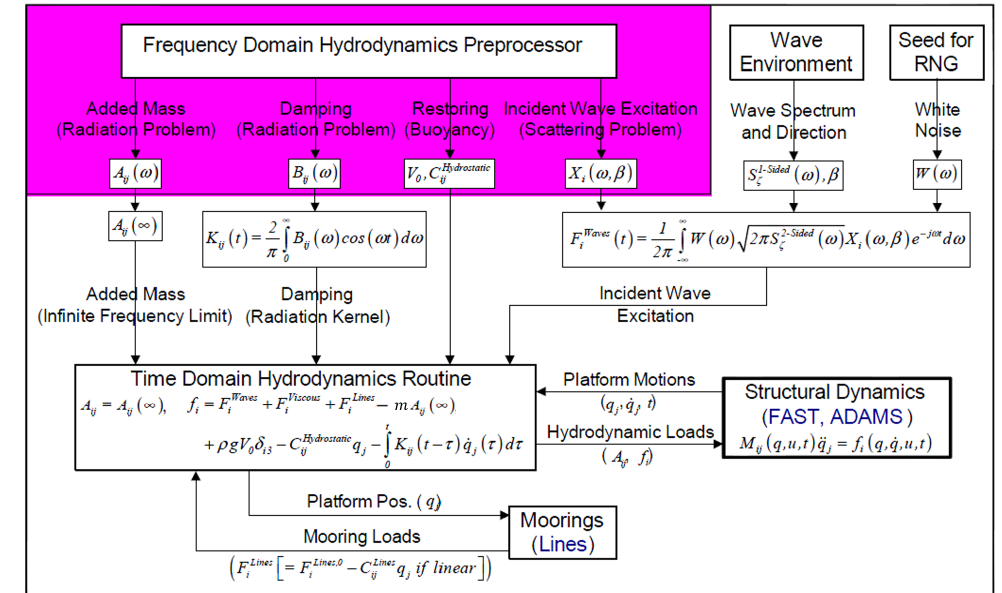
Figure 3. Flowchart of calculations for the total external loads on the support platform.